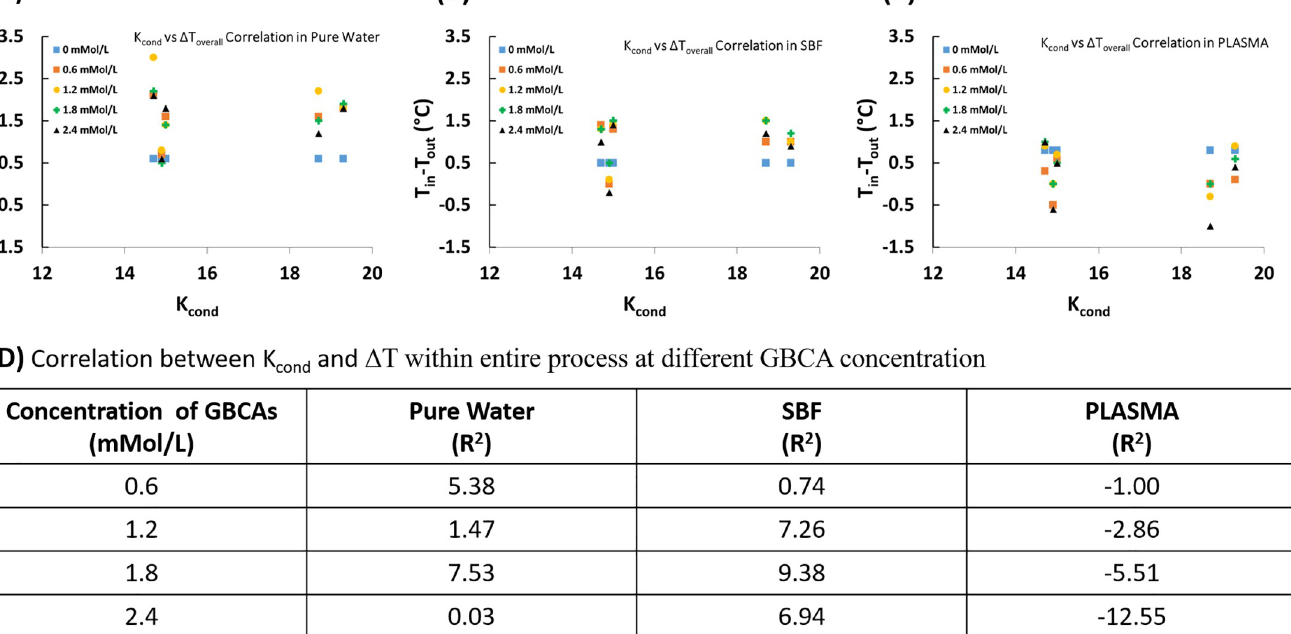
Fig 4. Scatter plots showing correlation between conditional stability constant (K cond ) and temperature difference ( Δ T overall in entire process in different media. (A) pure water, (B) Simulated body fluid-SFB, (C) plasma), and (D) relevant correlation coefficients.